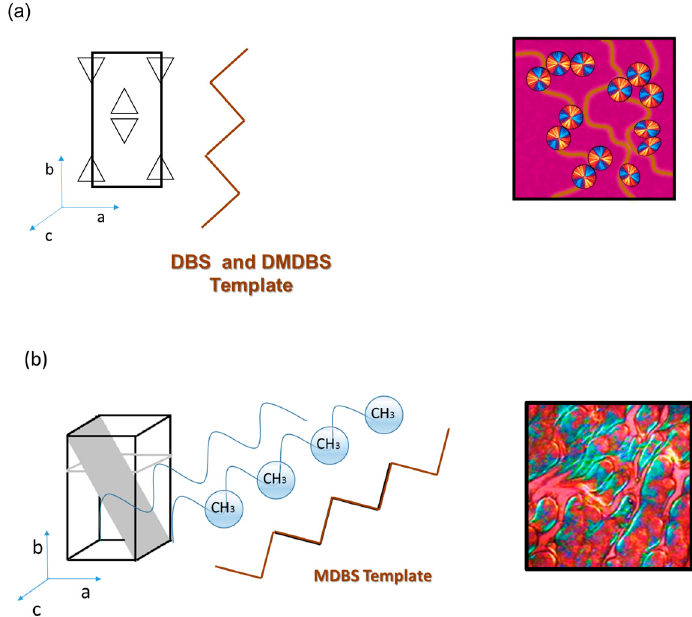
Figure 7. Scheme of the stabilization of a polypropylene wax between the cleft interfaces of the fibrillar templates. Interface match with sorbitol templates: ( a ) stabilization by match with the helix of the iPP wax, of DBS, or DMDBS, and ( b ) stabilization by match with the methyl groups of MDBS.